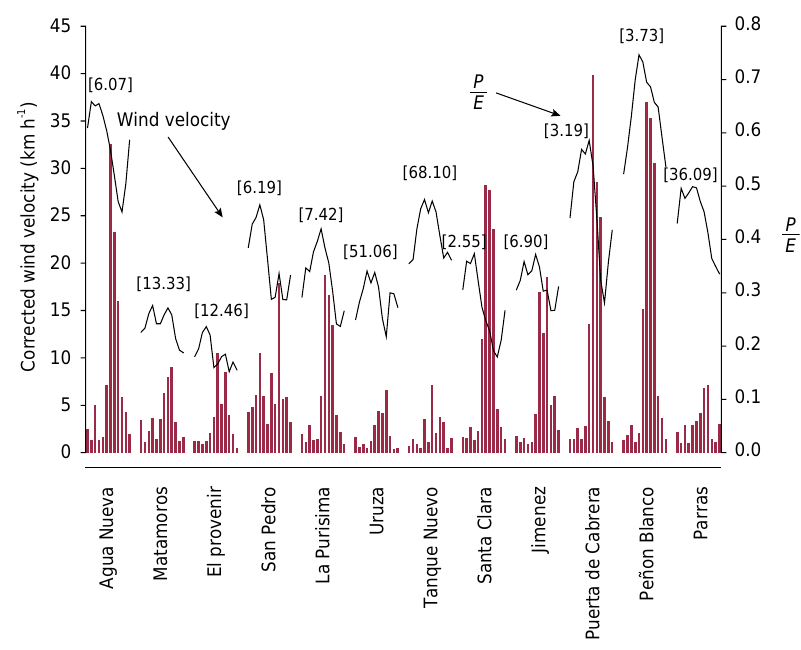
Figure 3. Monthly variation of the precipitation effectiveness ( P for the weather stations considered within the study area. The number in brackets is the C value for the specific weather station. Each bar represents a month for a given